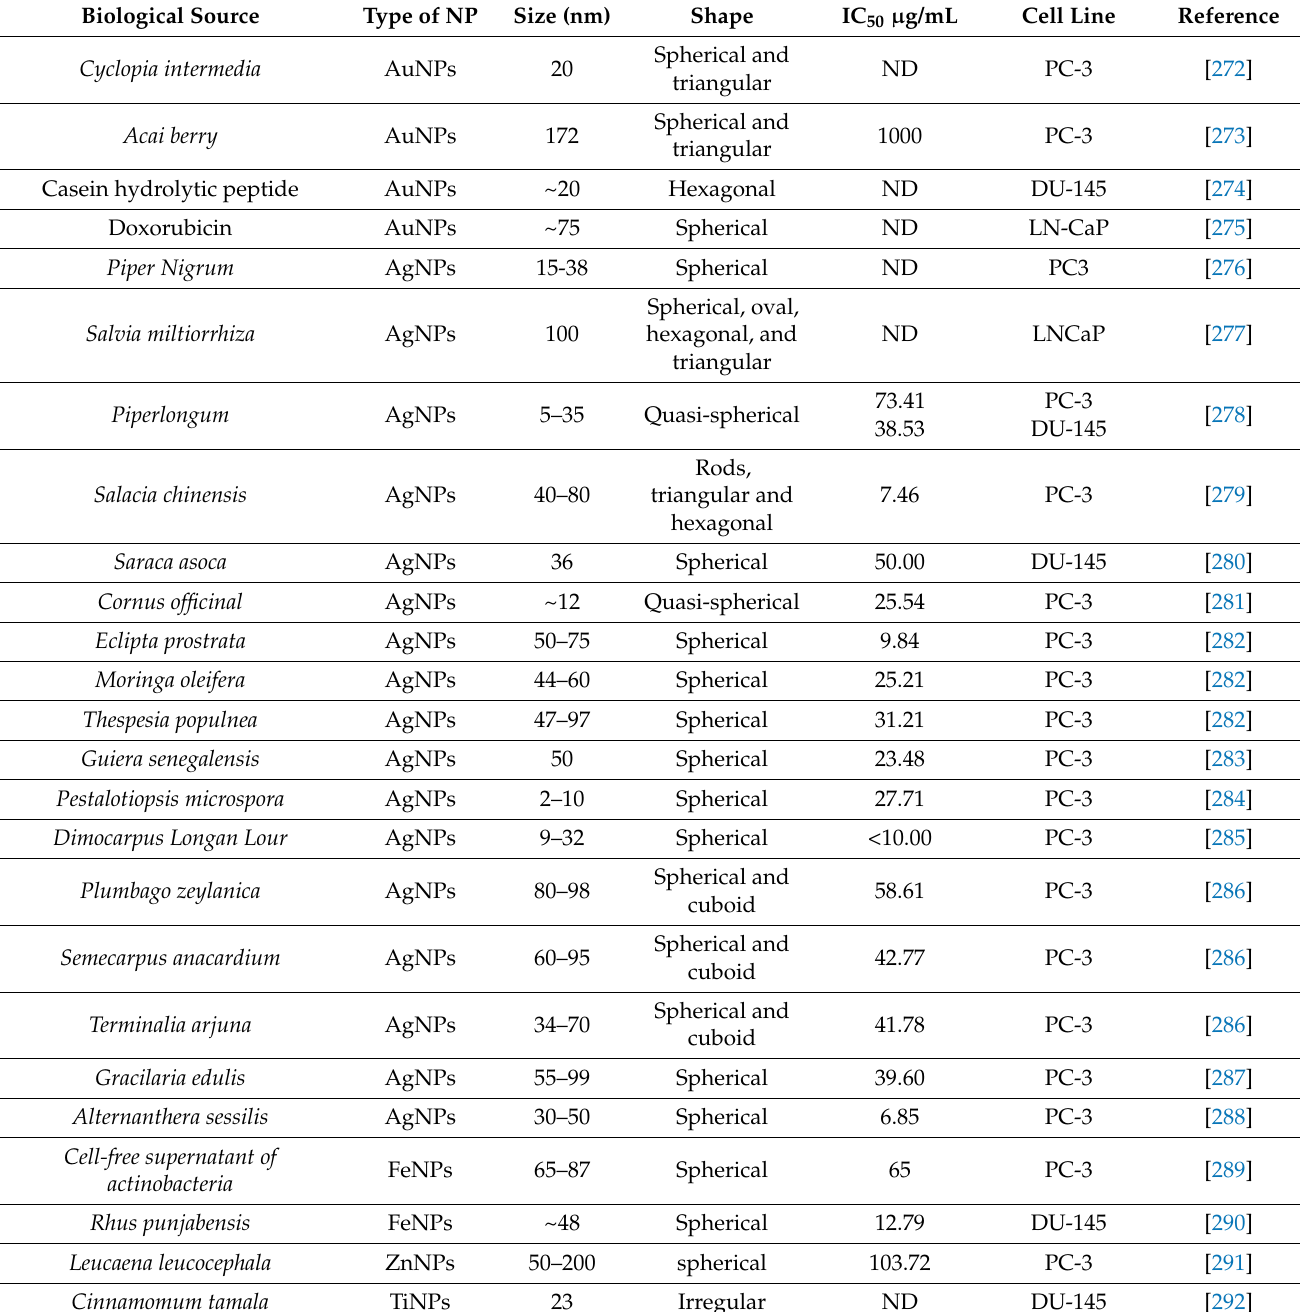
Table 8. Evaluation of green biogenic MNPs in prostate cancer cells; biological source, NPs characteristics, IC 50 , and in vitro models. Biological